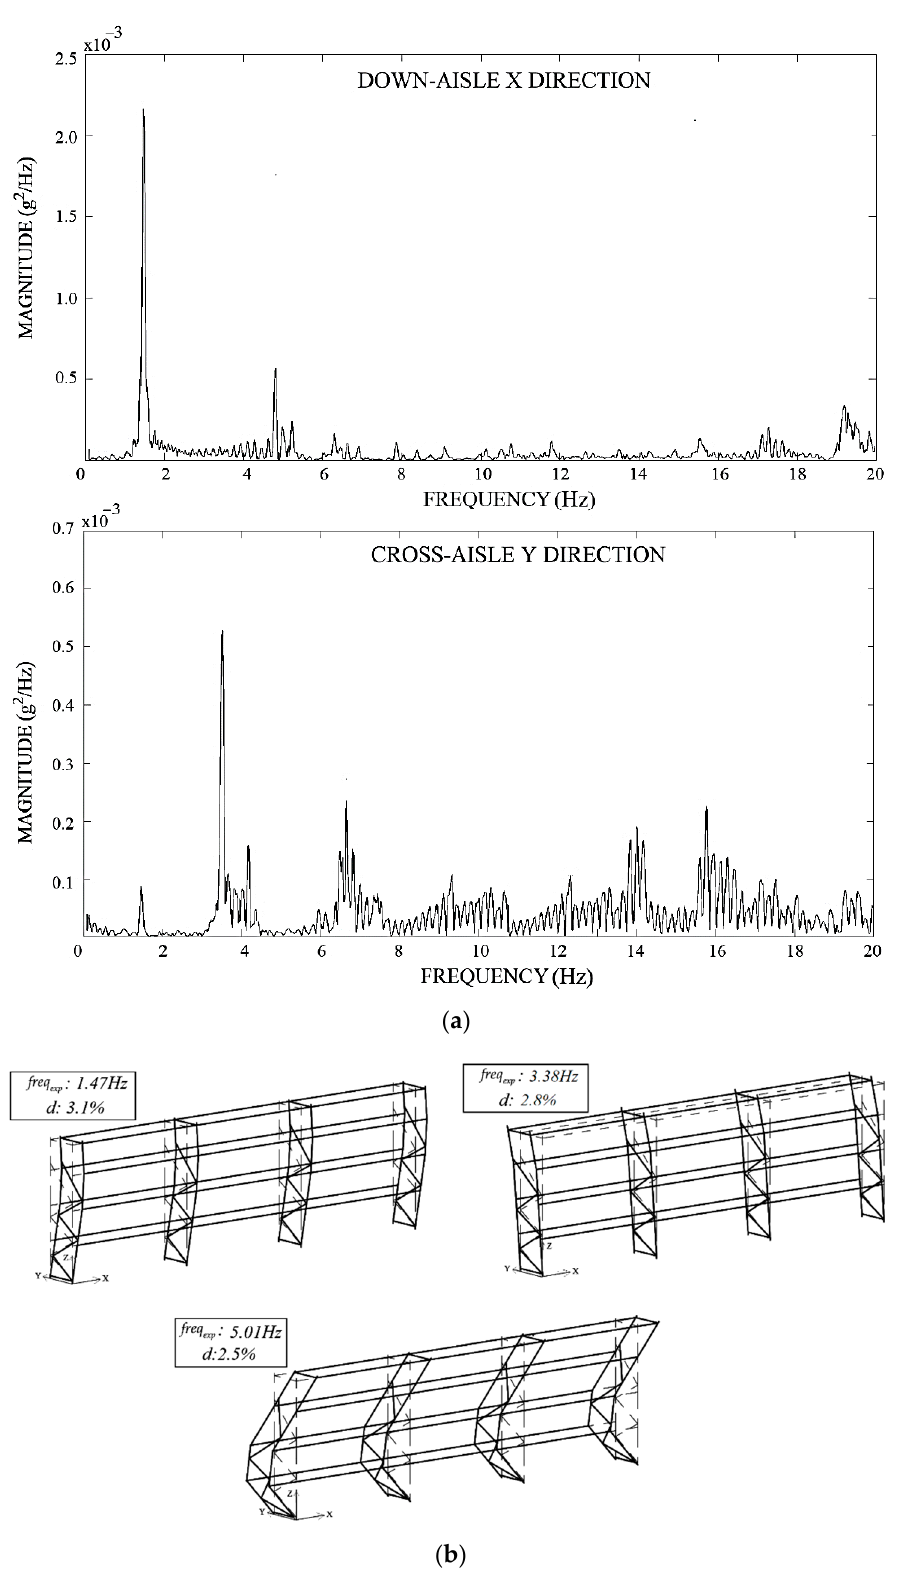
Figure 8. Example of an output obtained from the tests in longitudinal direction.